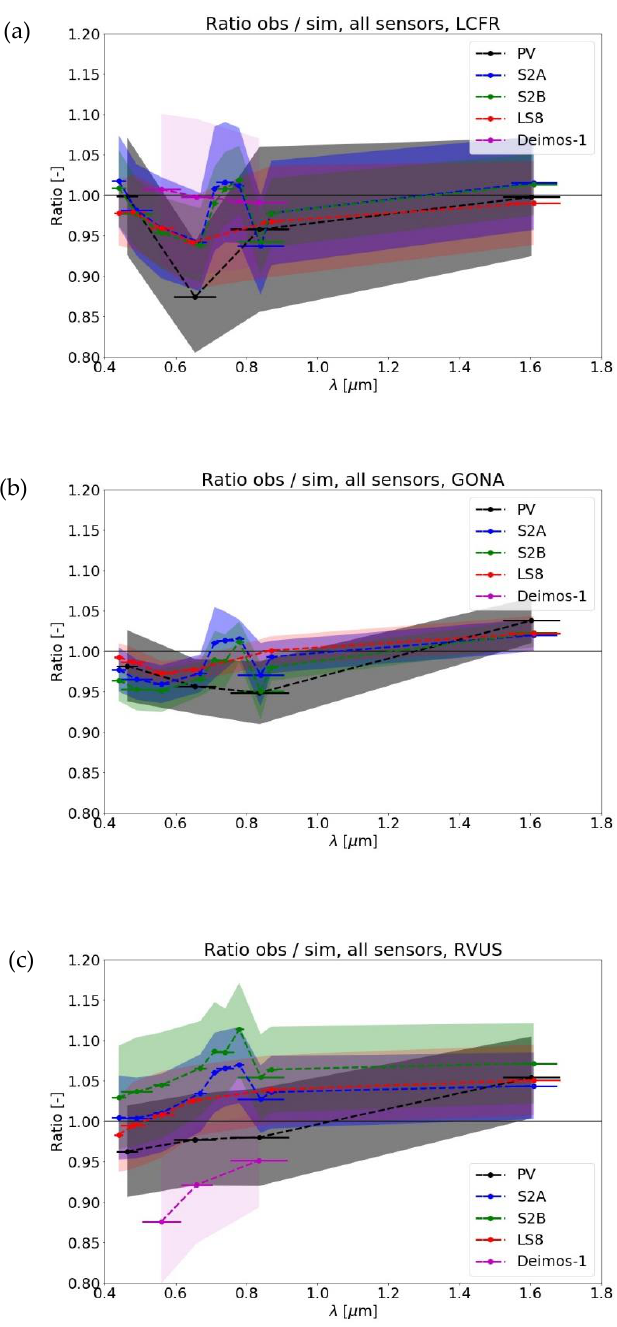
Figure 3. Ratio between the observed and RadCalNet-simulated TOA reflectances as a function of wavelength for PROBA-V (PV), Sentinel-2A (S2A), Sentinel-2B (S2B), Landsat 8 (LS8), and Deimos-1 over La Crau (LCFR) (top panel, ( a ), Gobabeb (GONA) (middle panel, ( b ), and Railroad Playa (RVUS) (bottom panel, ( c ). The shaded areas denote the ± 1 standard deviation ( σ ) of the obtained ratios. Note that no Deimos-1 data were available for GONA.